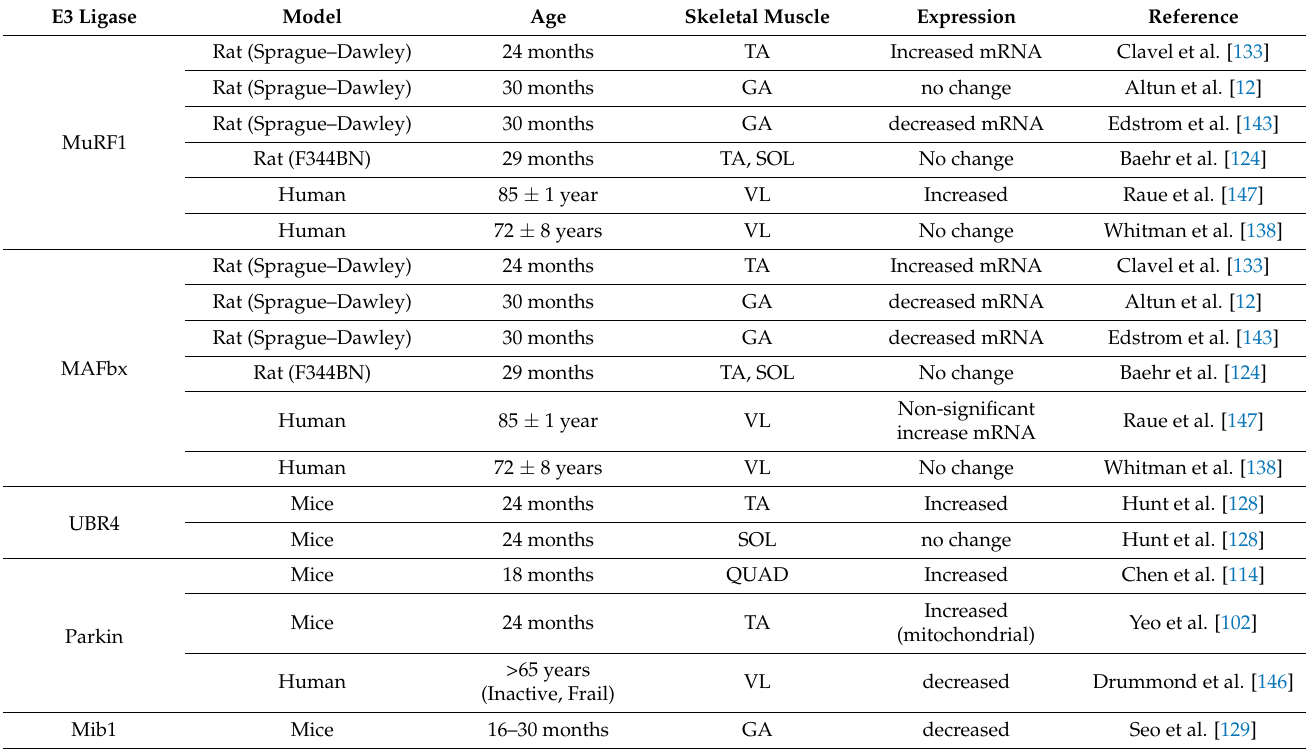
Table 2. Summary of identified E3 ubiquitin ligases involved in aging skeletal muscle to